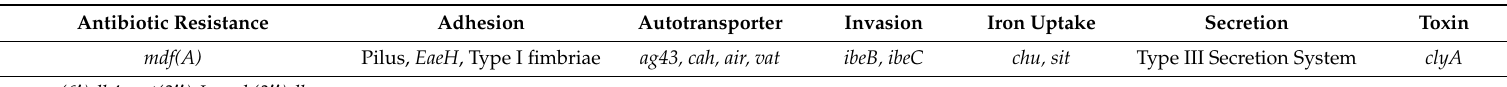
Table 2. Antibiotic resistance genes and virulence determinants detected on the chromosome and the plasmid of the isolate 550.